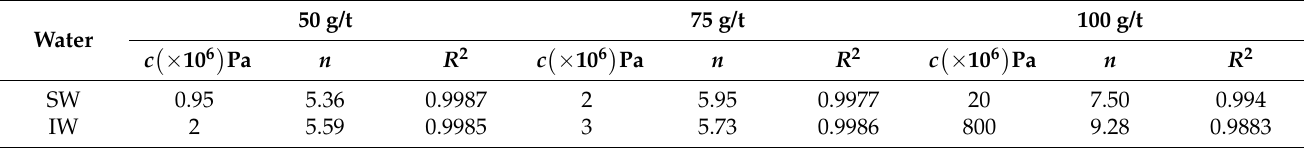
Table 3. Power law parameters ( c and n ) and goodness of fit ( R 2 ) for the compressive yield stress of kaolin suspensions with three flocculant doses in SW and